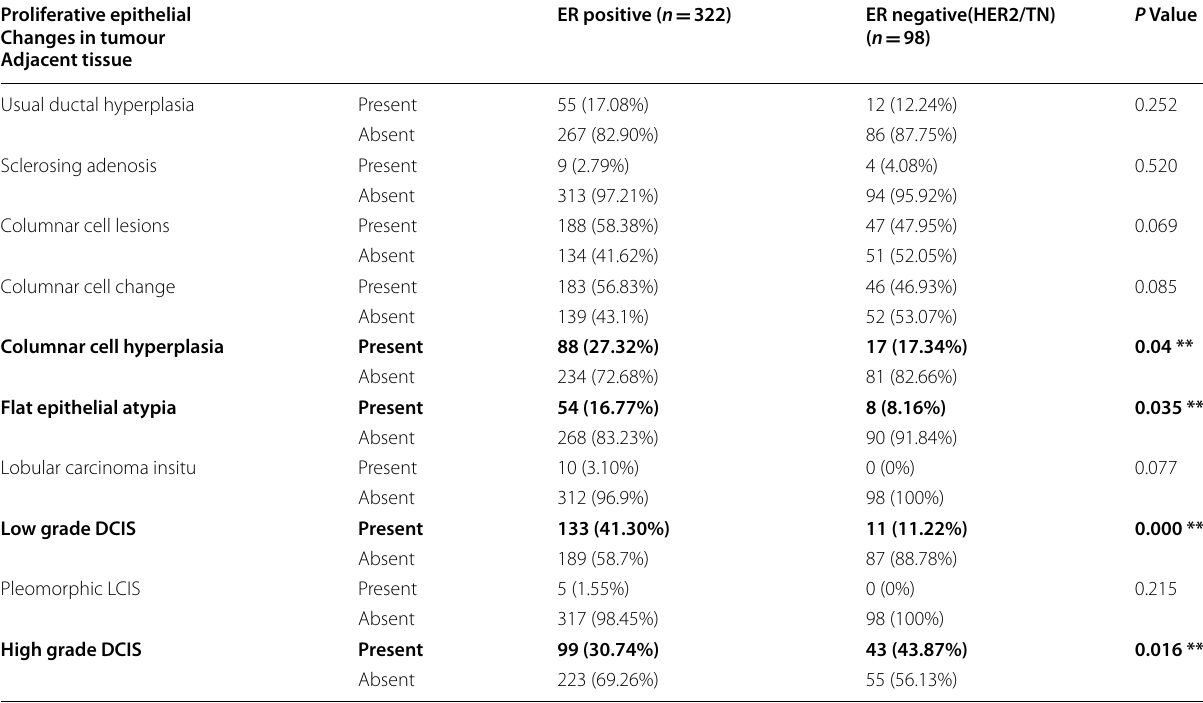
Table 2 Association between proliferative epithelial changes in tumour adjacent tissue and ER status of the tumour Proliferative epithelial Changes in tumour Adjacent tissue